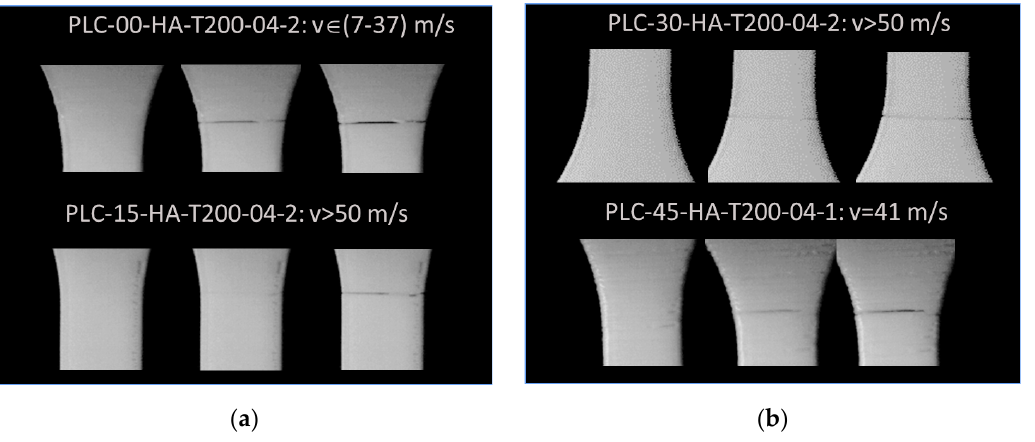
Figure 18. High-speed camera recording showing the crack behaviour of PLC printed using vertical orientation (HA) for different in-plane printing angles: ( a ) θ = 0 °, θ =15°, ( b ) θ = 3 0°, θ =45°.